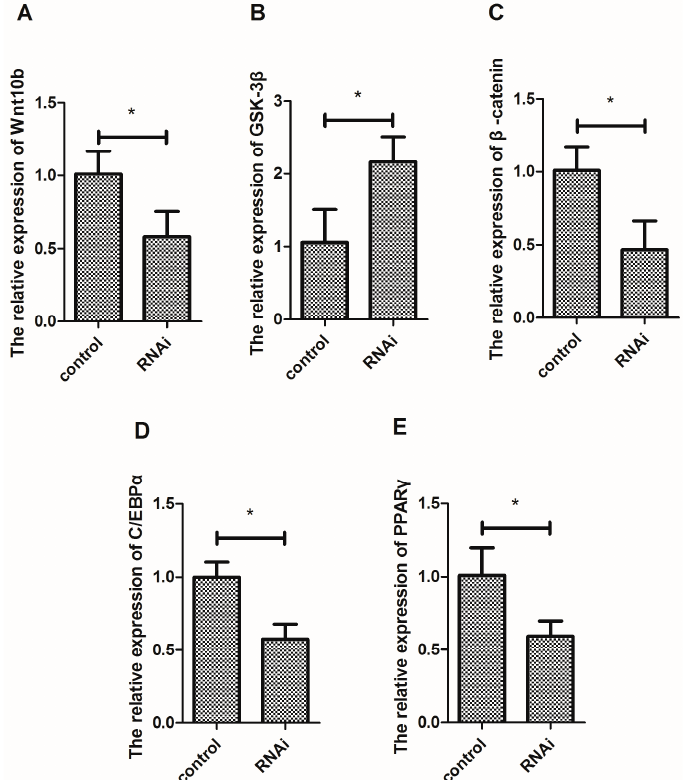
Figure 5. Effect of Wnt10b gene interference on the mRNA expression of Wnt10b, GSK-3 β , β -catenin, C / EBP α , and PPAR γ in the muscle of zebrafish. ( A ) Wnt10b; ( B ) GSK-3 β ; ( C ) β -catenin; ( D ) C / EBP α ; ( E ) PPAR γ . Values are expressed as means ± s.e.m. ( n = 4). Statistically significant differences are denoted by an asterisk (* p < 0.05).